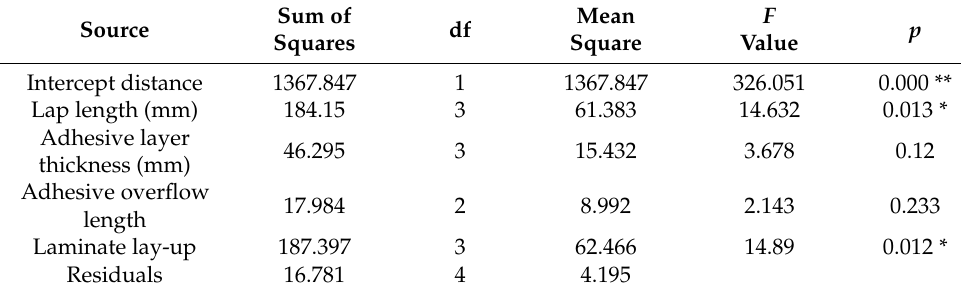
Table 5. Multifactor analysis of variance results for orthogonal